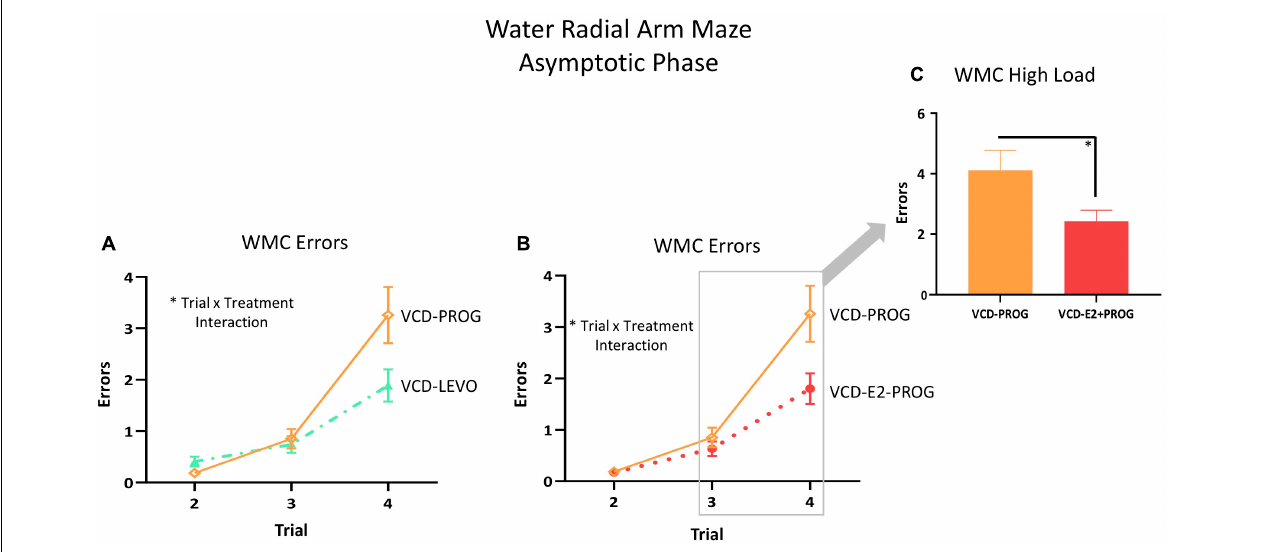
FIGURE 4 | WMC Errors During the Asymptotic Phase. (A) While there was no main effect of Treatment collapsed across trials for any two-group comparison, there were Trial × Treatment interactions between the VCD-LEVO and VCD-PROG groups ( p < 0.05) and (B) VCD-PROG and VCD-E2 + PROG groups ( p < 0.05). (C) When the High Load trials (Trials 3 plus 4) were assessed, VCD-PROG rats made more WMC errors than VCD-E2 + PROG rats ( p < 0.05). Significance: ∗ = p <